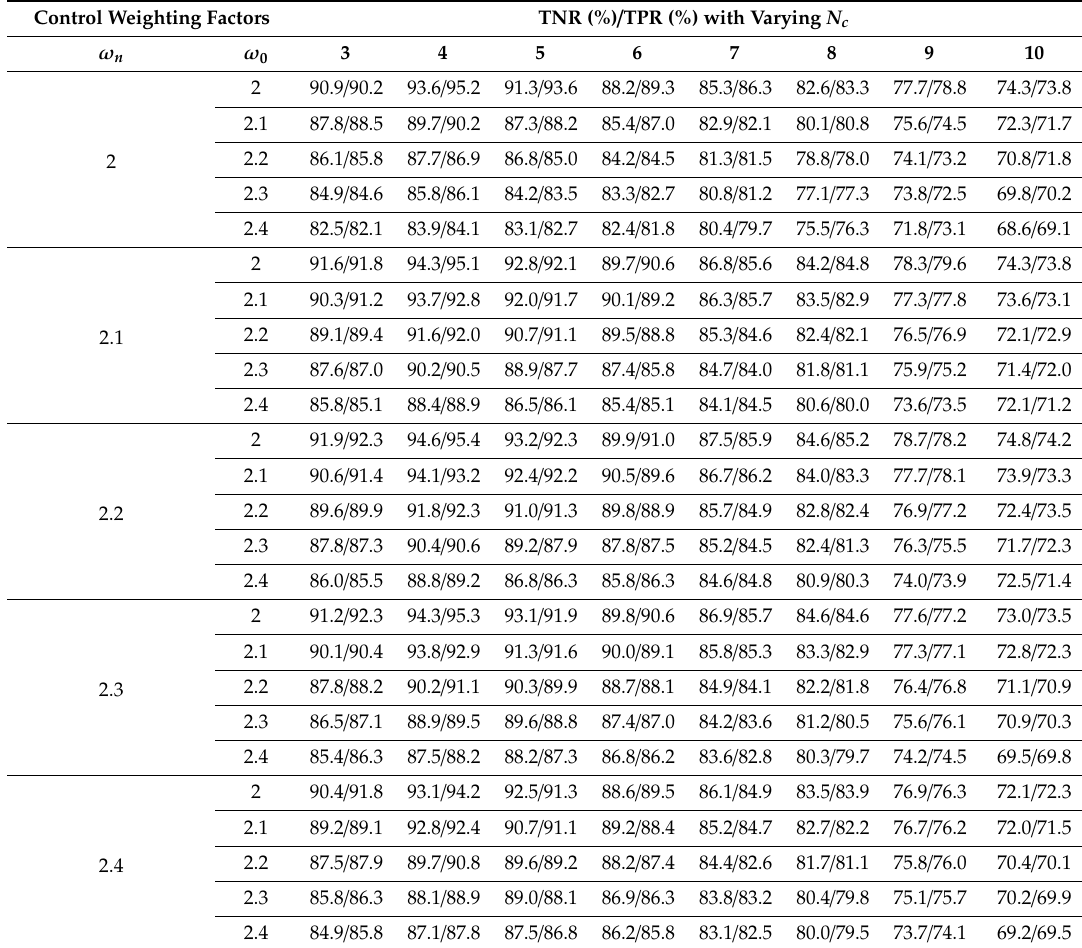
Table 2. Performance evaluation of the binary detection model using CGAN-improved fuzzy c-means clustering (IFCM) with varying N c , ω n , and ω 0 values using the SVD database. (a) Fixed ω n = 1.8. (b) Fixed ω n = 1.9. (c) Fixed ω n = 2.0. (d) Fixed ω n = 2.1. (e) Fixed ω n = 2.2.